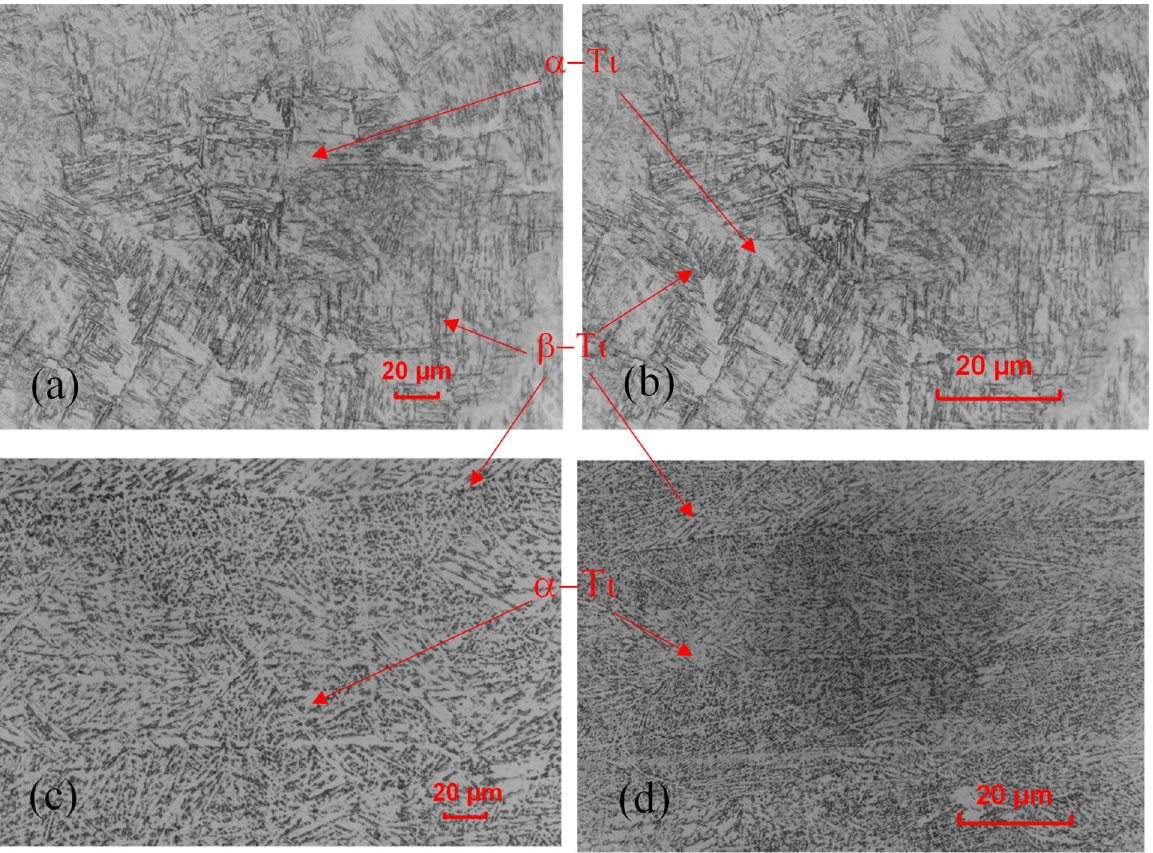
Figure 4. Microstructure of the Ti–6Al–4V alloy in the manufacturing state (as built). ( a ) XY plane 500 × ; ( b ) XY plane 1000 × ; ( c ) XZ plane 500 × ; ( d ) XZ plane 1000 × .